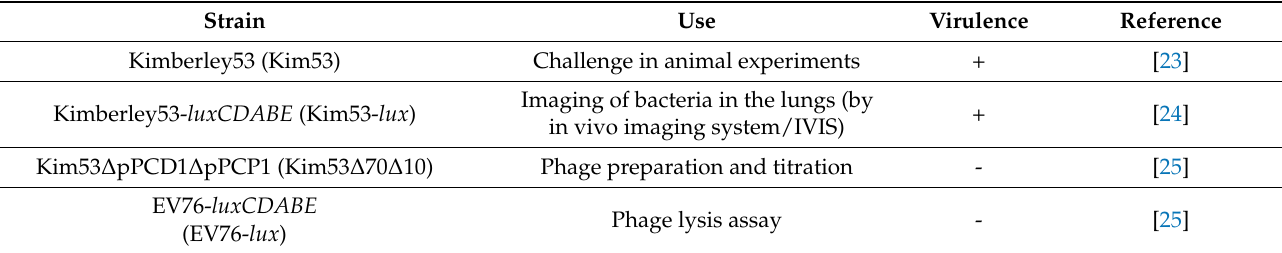
Table 1. Y. pestis strains used in the present study. Strain Use Virulence Reference Challenge in animal experiments + Imaging of bacteria in the lungs